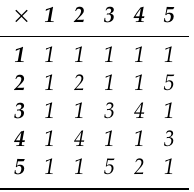
Table 3. The operation × on S